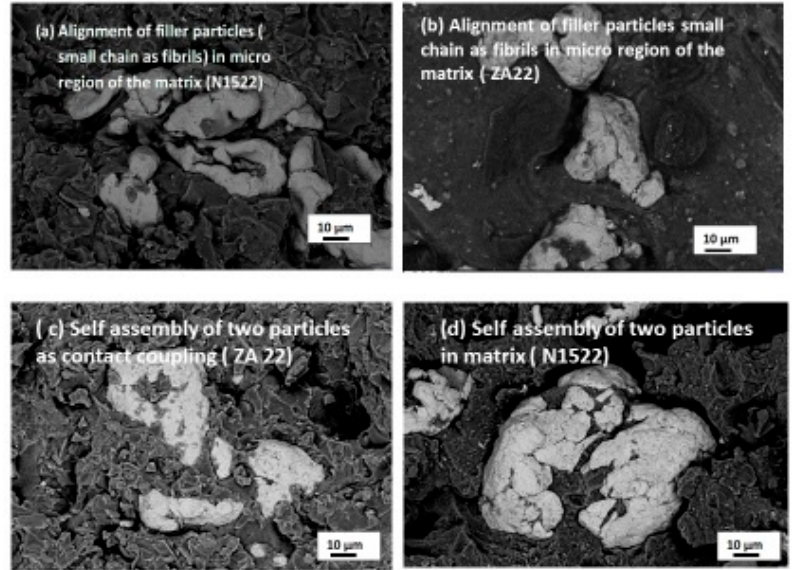
Figure 11. ( a – d ) Self-assembled structure of iron particles (affine coupling, microscopic behavior) in MRE composite.